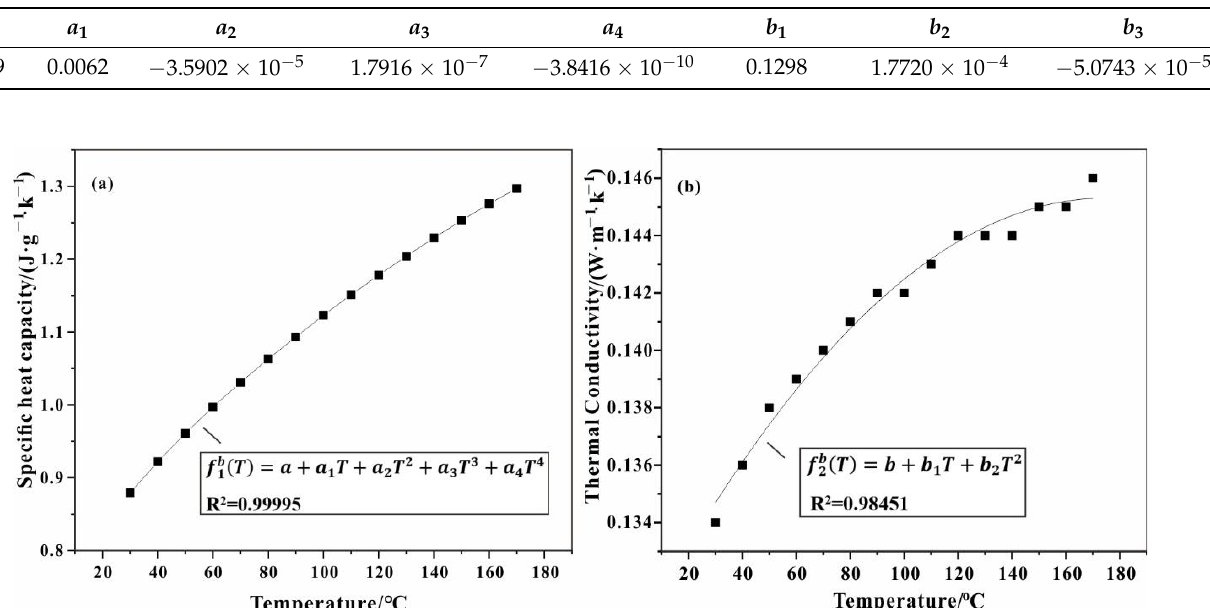
Figure 1. ( a ) Specific heat capacity curve of PS; ( b ) thermal conductivity curve of PS.